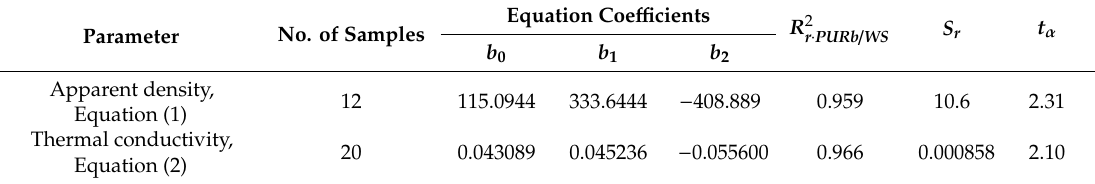
Table 5. Statistical data of apparent density and thermal conductivity